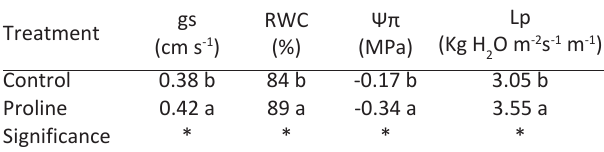
Table 1 - Effect of exogenous L-Proline on stomatal conductance (gs), relative water content (RWC), osmotic potential (Ψπ) and water conductivity (Lp) of rose cut stems Treatment